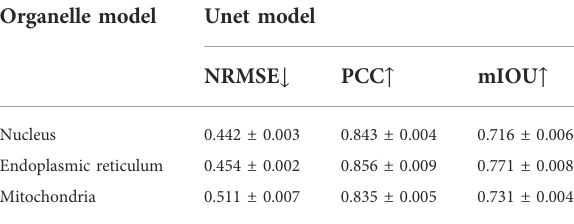
TABLE 4 Comparison of quality measures for labeling-free prediction results with the Unet model. Organelle model